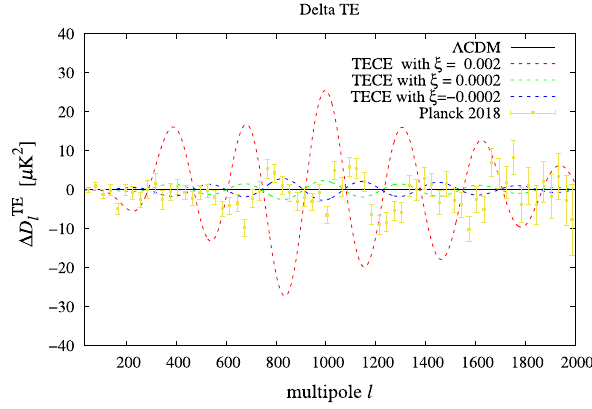
Fig. 10 Legend is the same as Fig. 5 but in the TECE model with a set of ξ